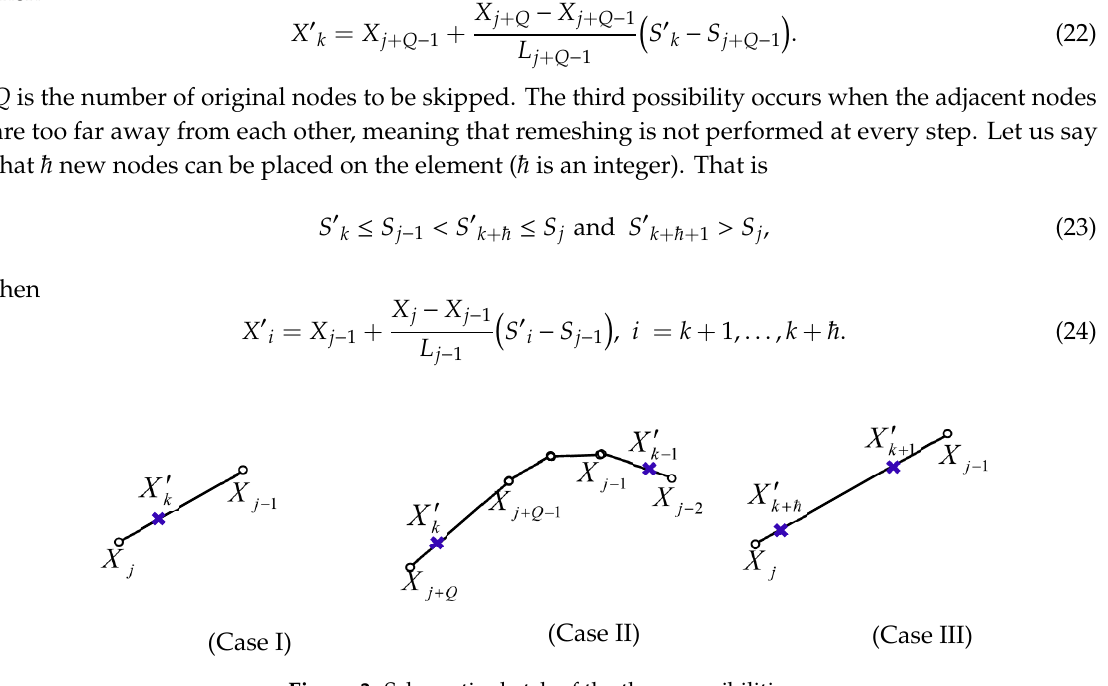
Figure 3. Schematic sketch of the three possibilities.